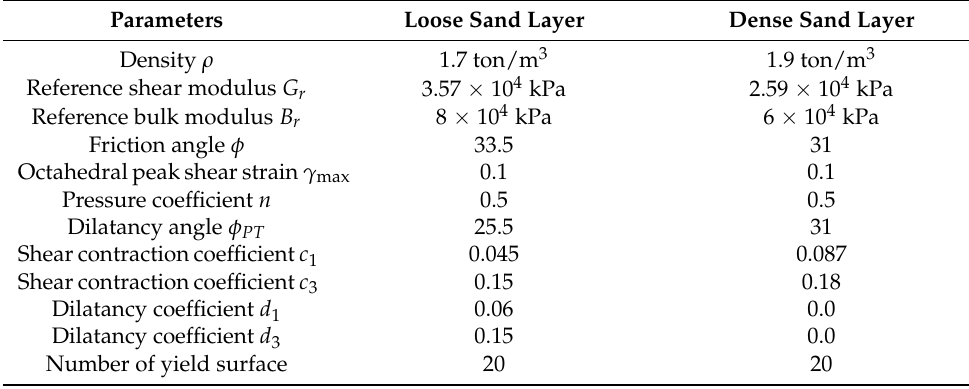
Table 3. Material parameters of the model.